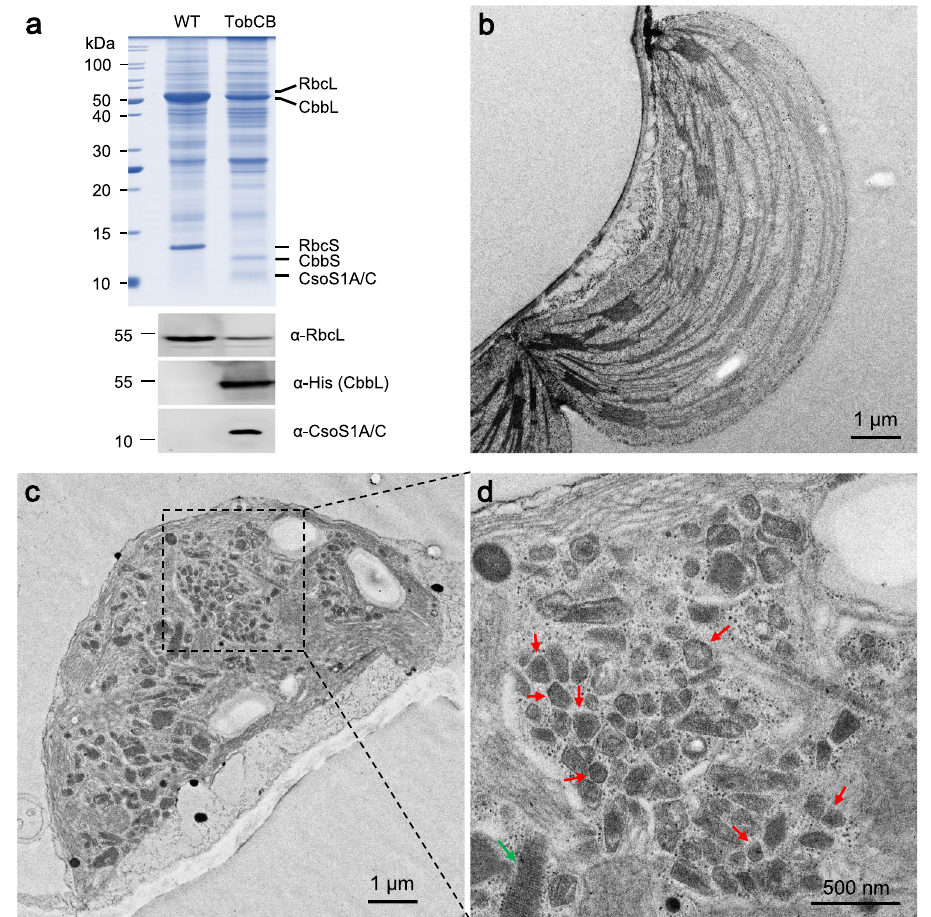
Fig.2|Expressionof α -carboxysomestructuresintobaccochloroplasts.a SDS- PAGE (top) and immunoblot analysis (bottom) of total soluble proteins of the WT and TobCB leaves indicated the expression of α -carboxysome proteins in the chloroplast transformant TobCB. b Representative transmission electron micro- graph (EM) of leaf sections from WT tobacco. c , d EM of leaf sections from the chloroplast transformant TobCB. Carboxysome-like structures were clearly observed in the chloroplasts of the TobCB transgenic line, whereas the WT